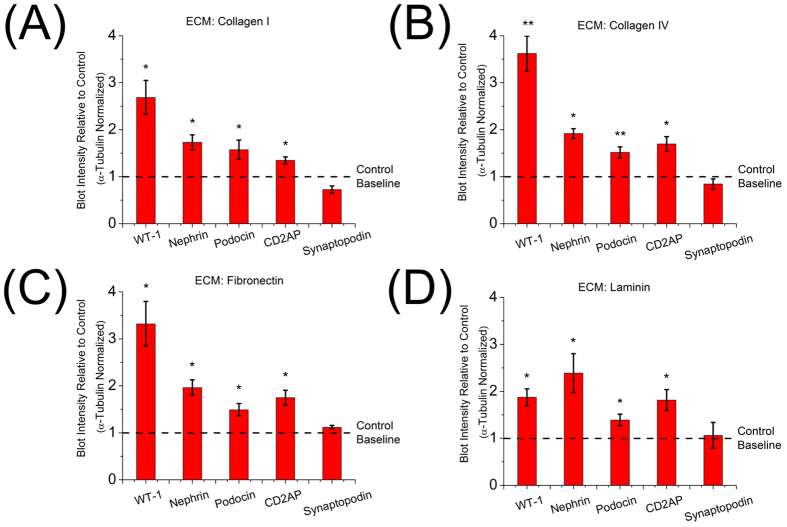
Extent of mechanotransduction is extracellular matrix independentECM coating with (A) collagen I of reduced density from 5 μg/cm2 to 1 μg/cm2: Upregulation for five protein markers are 2.7 ± 0.3, 1.8 ± 0.1, 1.7 ± 0.2, 1.3 ± 0.1 and 0.7 ± 0.1 respectively, (B) collagen IV (1 μg/cm2): Relative expression levels of WT-1, nephrin, podocin, CD2AP and synaptopodin by Western blots were 3.7 ± 0.4, 1.9 ± 0.1, 1.5 ± 0.1, 1.7 ± 0.1, 0.8 ± 0.1 respectively, (C) fibronectin (1 μg/cm2): Relative expression levels of WT-1, nephrin, podocin, CD2AP and synaptopodin were 3.3 ± 0.4, 2.0 ± 0.1, 1.5 ± 0.1, 1.7 ± 0.1, 1.1 ± 0.1 respectively, (D) laminin (1 μg/cm2): Relative expression levels of WT-1, nephrin, podocin, CD2AP and synaptopodin were 1.8 ± 0.2, 2.4 ± 0.4, 1.4 ± 0.1, 1.8 ± 0.2 and 1.1 ± 0.2 respectively. In all cases, statistical significance indicated changes of the ratios of five protein markers after normalization by those of control (two-tailed t-test, α = 0.05).